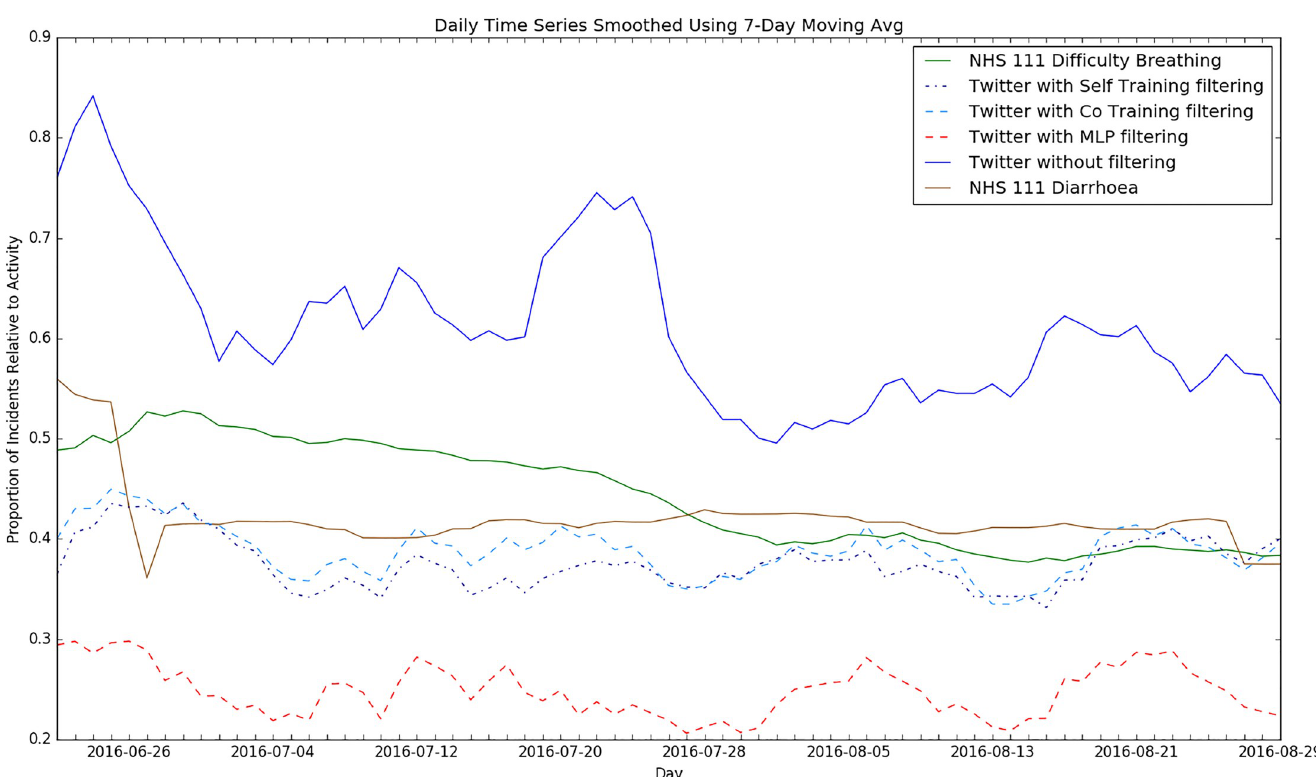
Fig 7. Time series plots comparing NHS 111 difficulty breathing data to signals from supervised and semi-supervised Twitter analysis and unrelated diarrhoea.